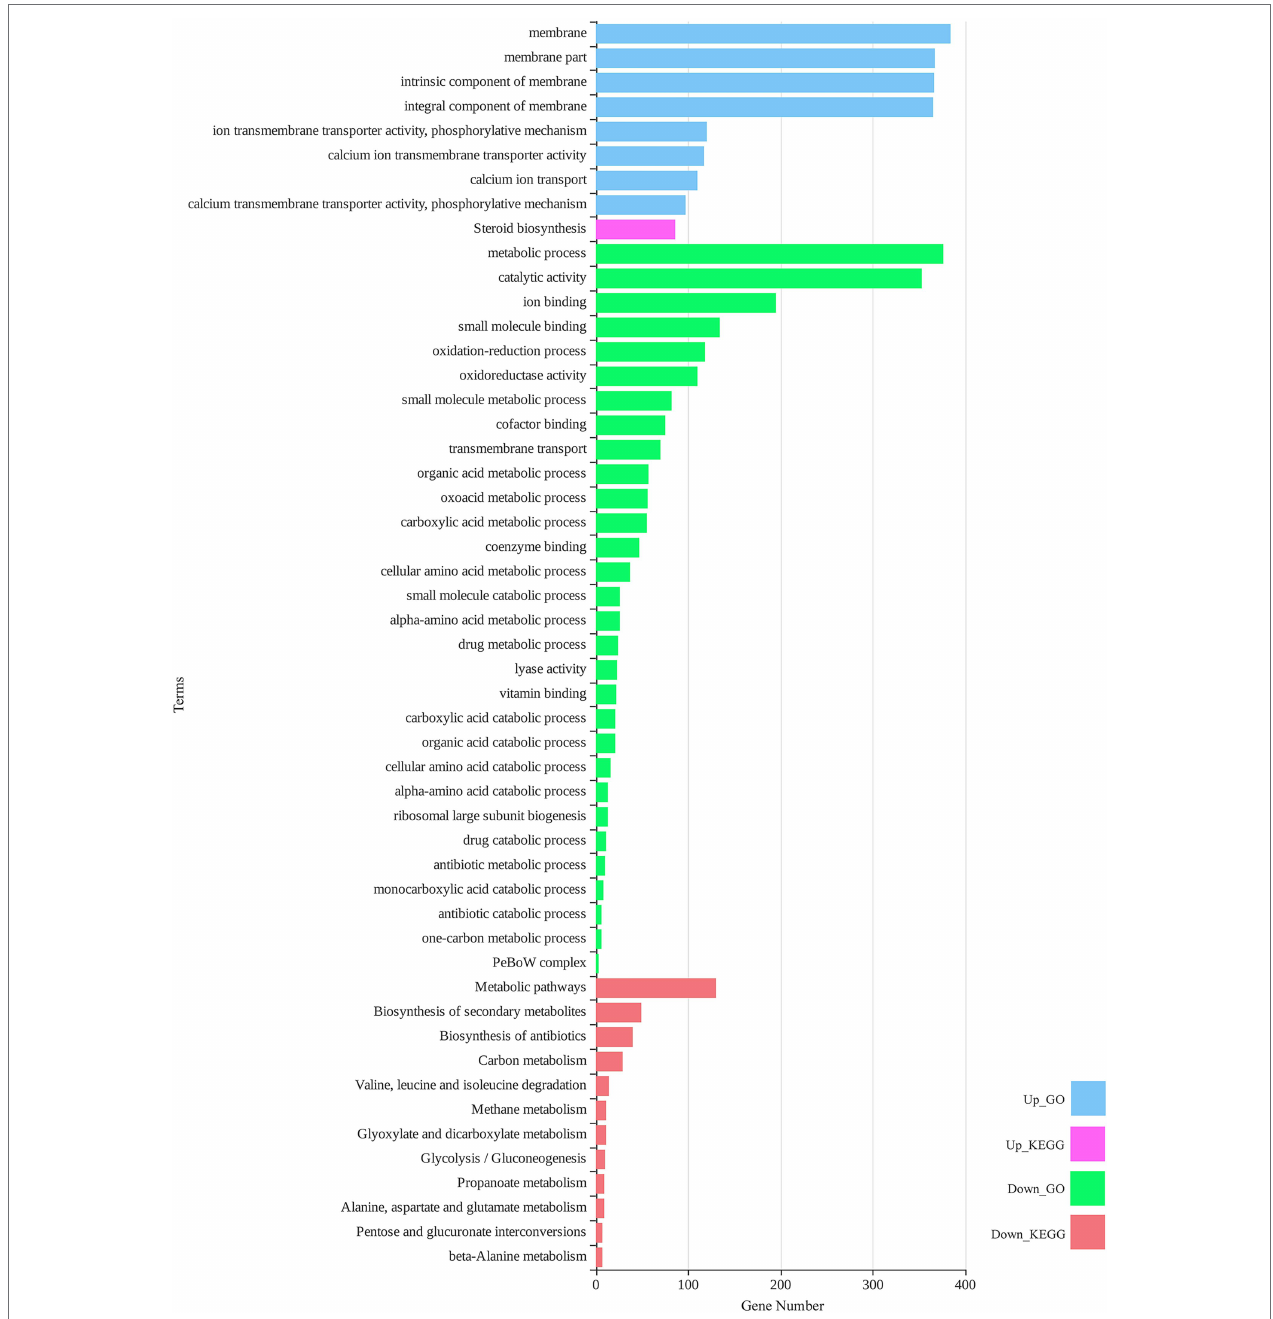
FIGURE 4 | Total significant (value of p < 0.05) gene ontology (GO) terms and Kyoto Encyclopedia Genes and Genomes (KEGG) pathways for differentially expressed genes of M. grisea in the presence of ZnO